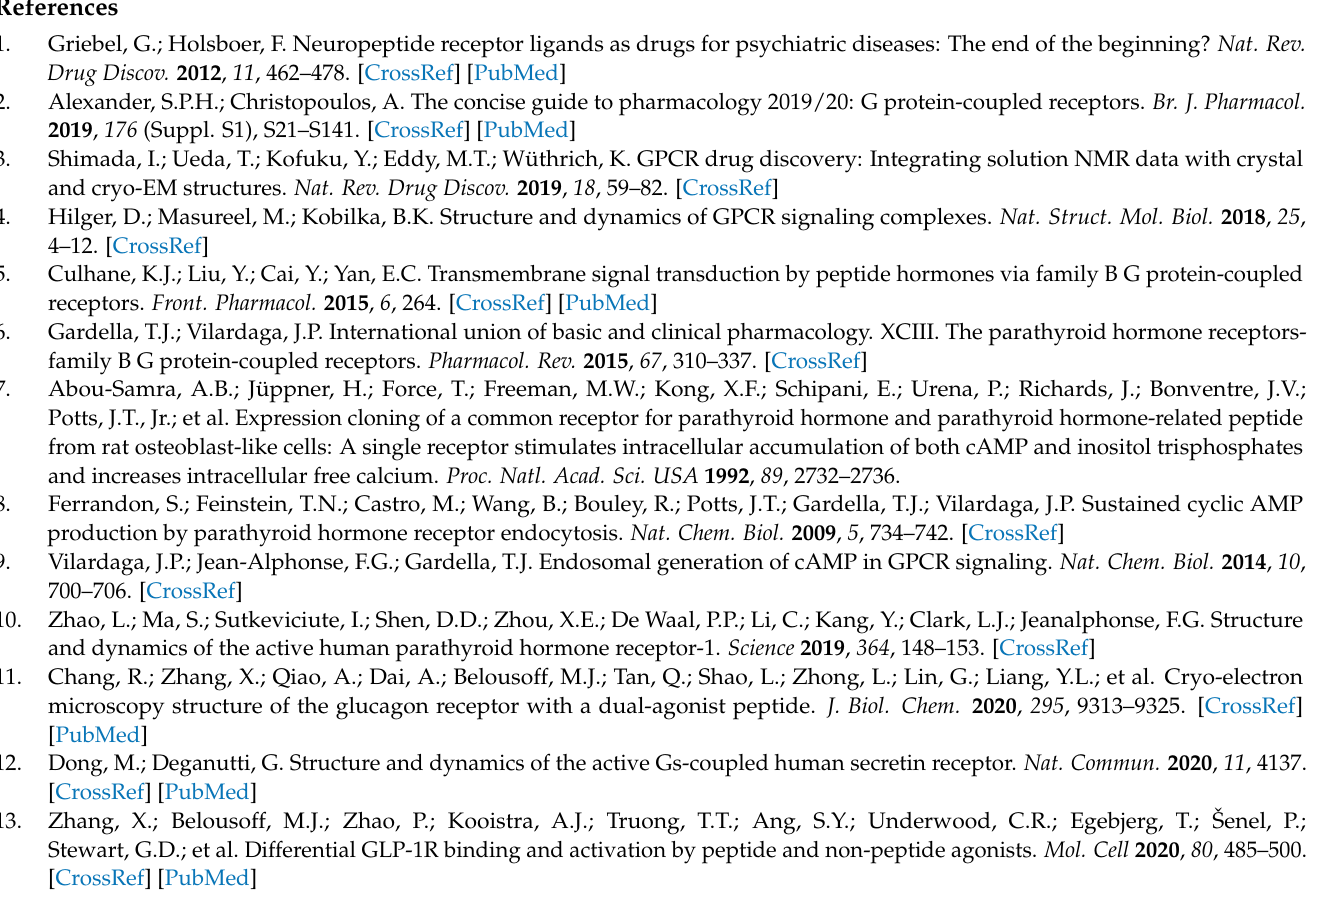
Figure S4: RMSFs of each system in the last 300 ns MD trajectories using average structure